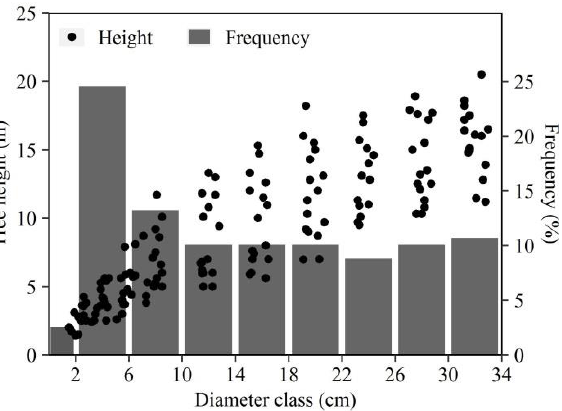
Figure 2. The scatter points depict height against diameter and the vertical bars represent the sample distribution across the 4-cm diameter class.